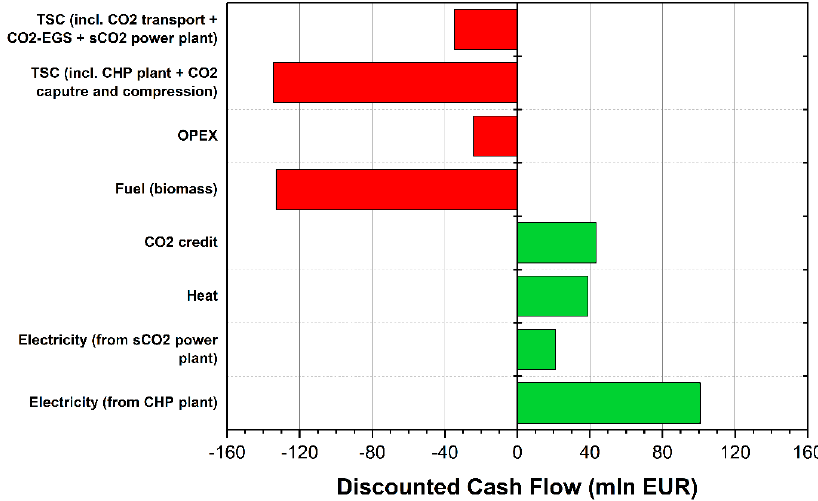
Figure 12. Discounted CF in the business as usual scenario in the analyzed system.